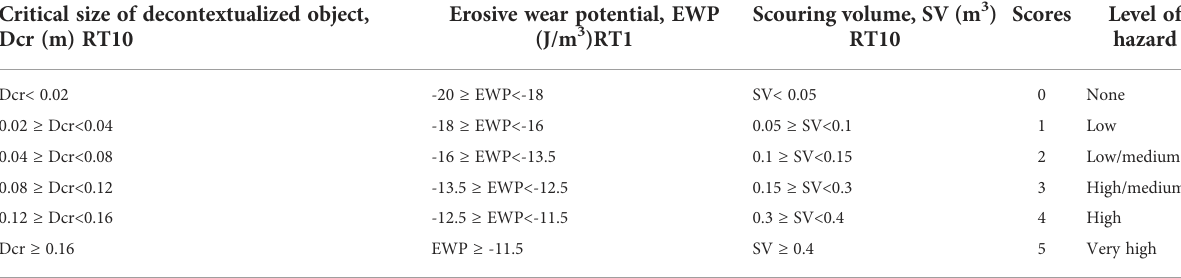
TABLE 1 Hazard indicator scores for decontextualization, erosive wear, and